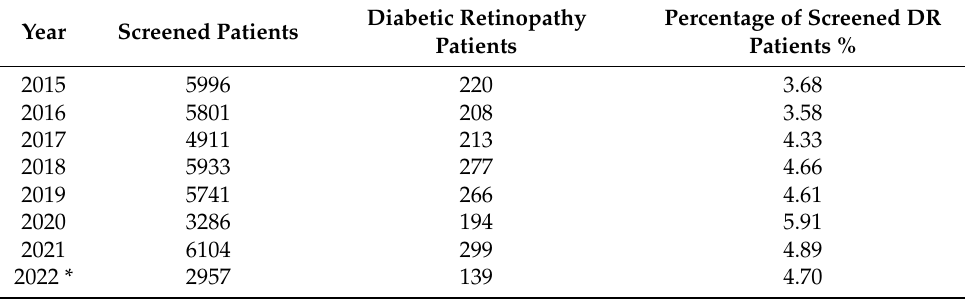
Table 3. Incidence of DR each year in the screened patients.